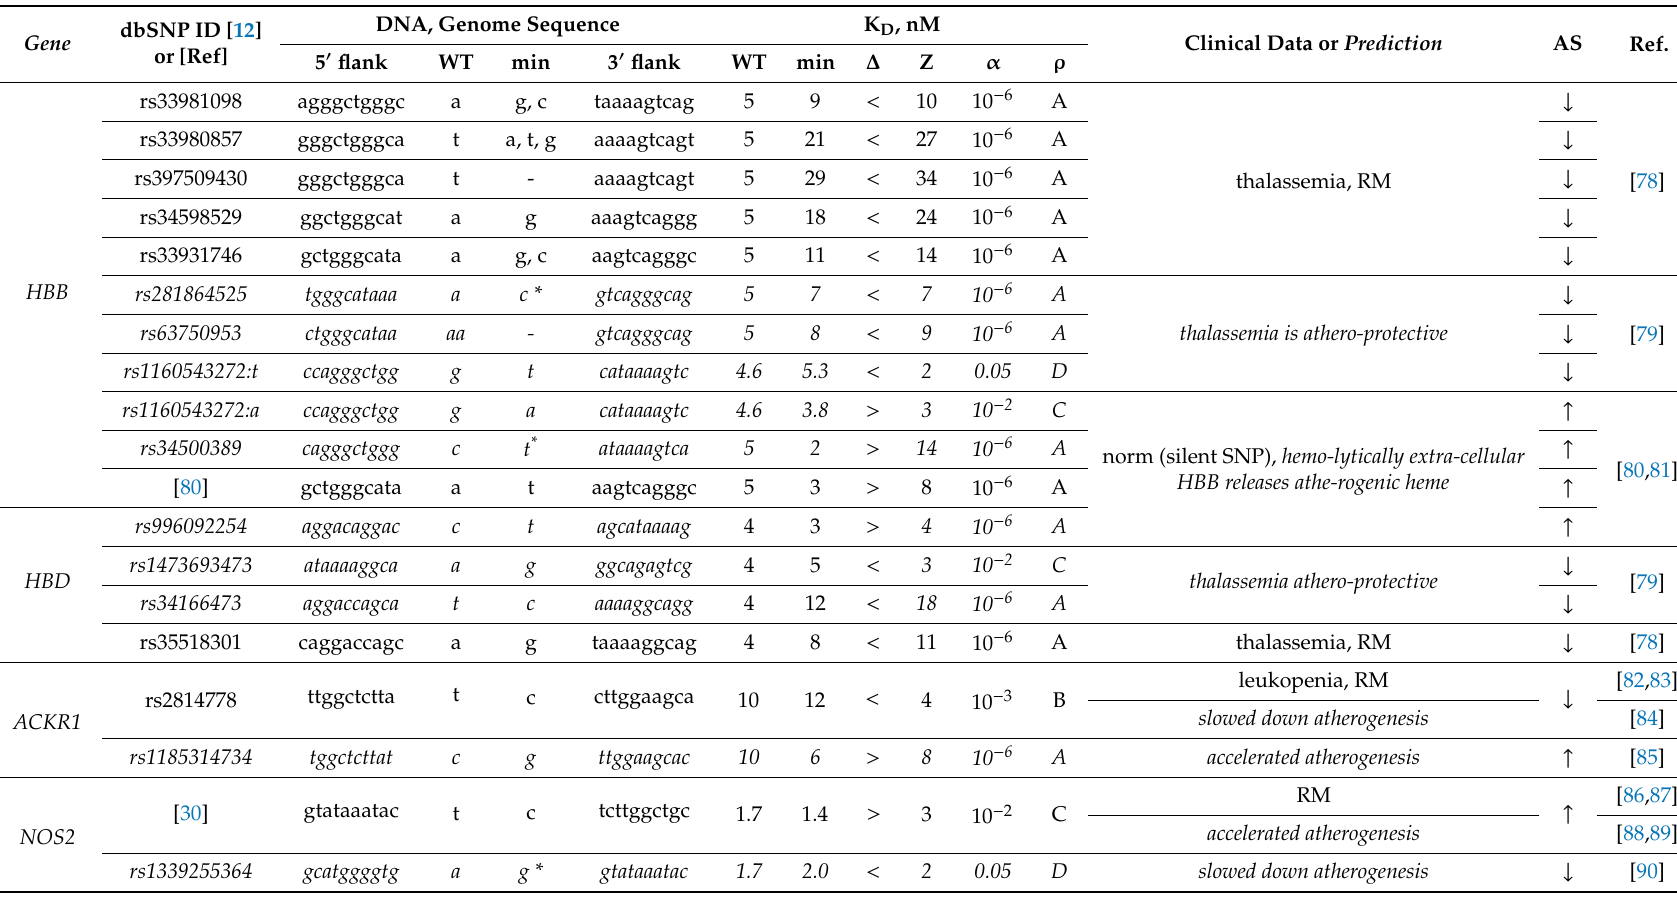
Clinical Data or Prediction AS